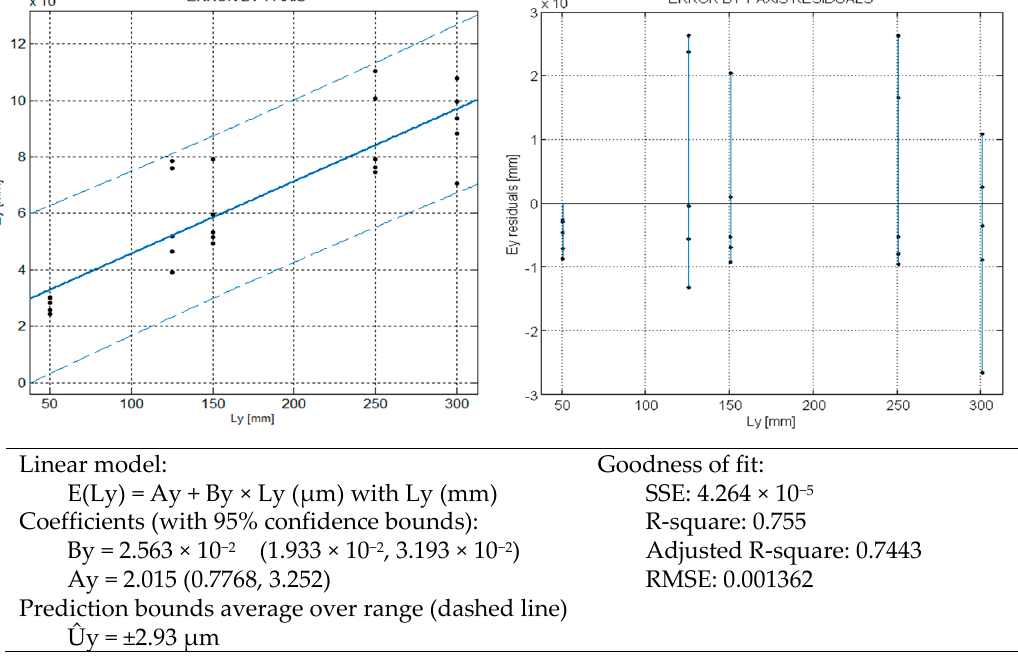
Figure 4. CMM error model by Y axis.